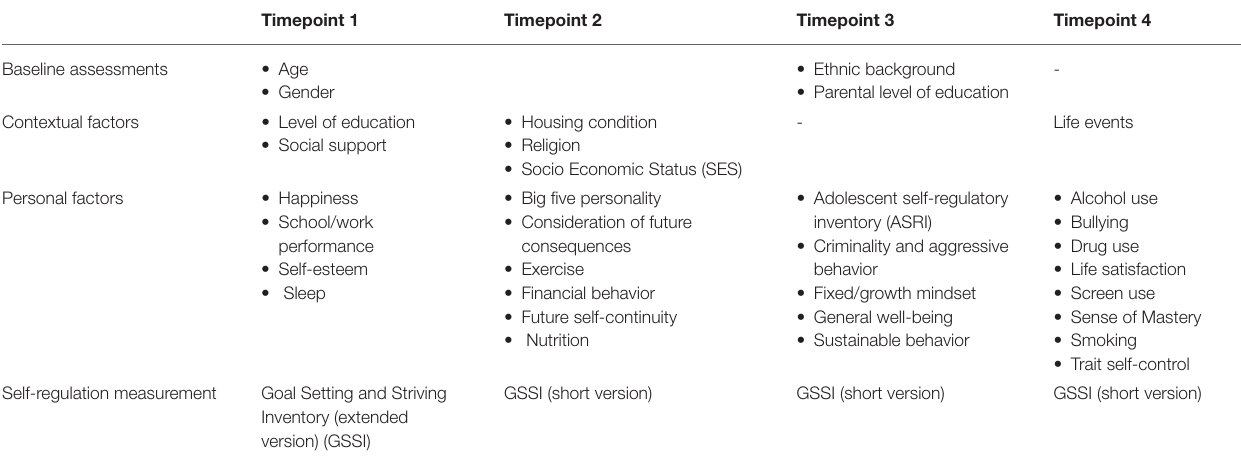
TABLE 1 | Schematic overview of the measurements per time-point for the first year of the